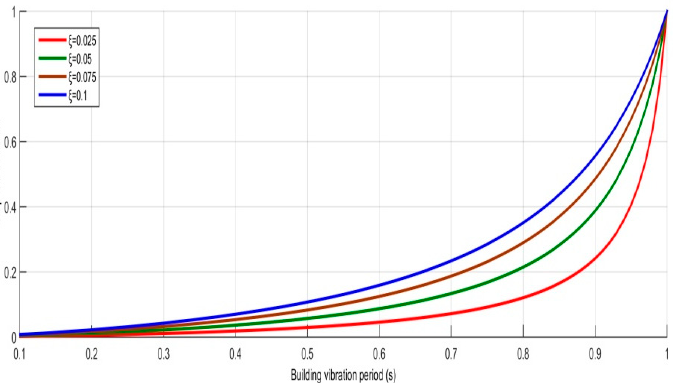
Figure 5. The limitation of the gap size index with different damping ratios for T j = 1 s.